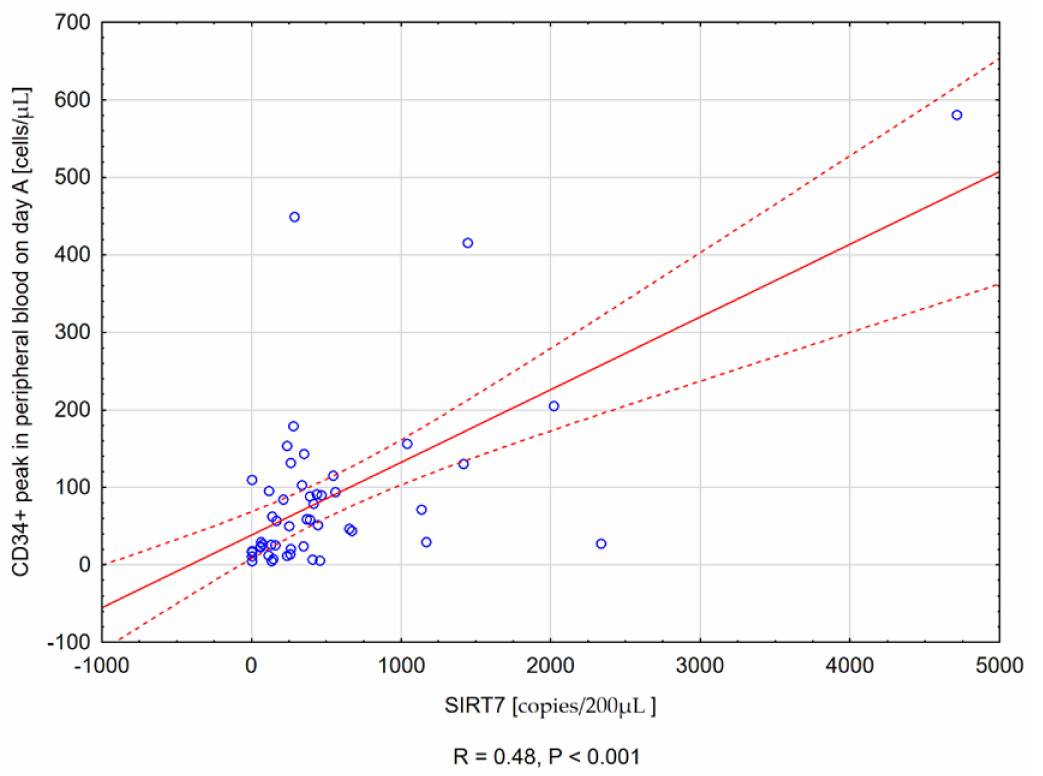
Figure 1. Scatter plots illustrating the positive correlation between sirtuin expression on day A and CD34+ peak in peripheral blood. A - SIRT5, B - SIRT6, C - SIRT7.